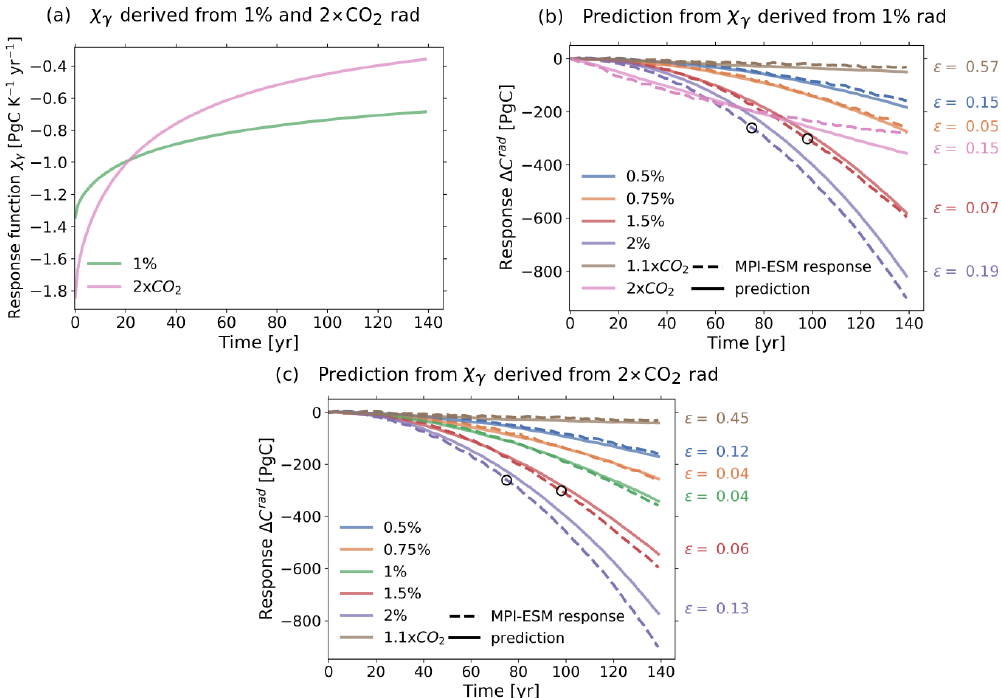
Figure 5. χ γ recovered from 1% and 2 × CO 2 rad experiments (a) and prediction of model responses using these recoveries of χ γ . Circles indicate the maximum value for which 1.5% and 2% responses are predictable according to the estimate of the linear regime (see text). At the right of (b, c) the relative prediction error (see Eq. 10) is indicated for the different experiments, calculated for the 1.5% and 2% rad experiments by considering only values preceding the